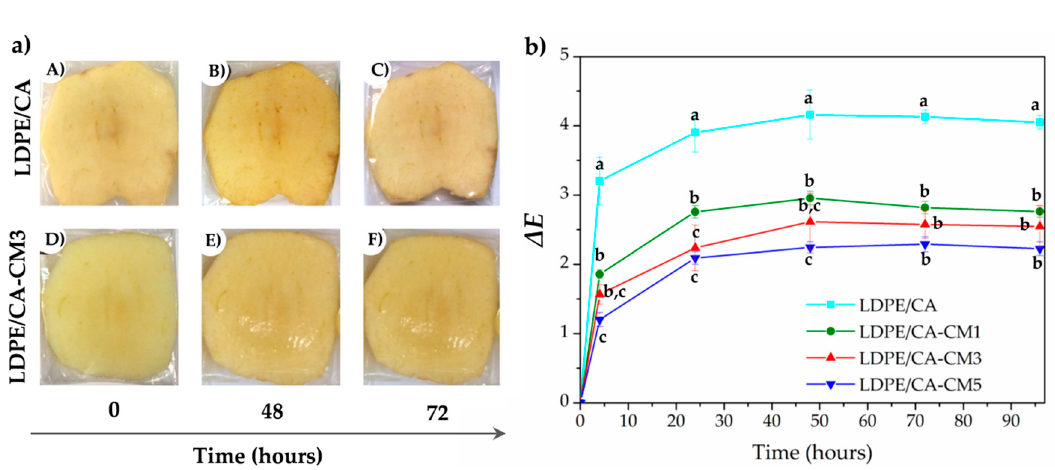
Figure 7. ( a ) Visual appearance of apples packed with LDPE/CA film: ( a )/( A ) immediately packed, ( a )/( B ) after 48 h and ( a )/( C ) after 72 h; and LDPE/CA-CM3 film: ( a )/( D ) immediately packed, ( a )/( E ) after 48 h, and ( a )/( F ) after 72 h packed; ( b ) Total color change evolution of fresh-cut apples packed with LDPE/CA and LDPE/CA-CM bilayer films over 96 h. a–c Different superscripts within the same day indicate significant differences between formulations ( p < 0.05).